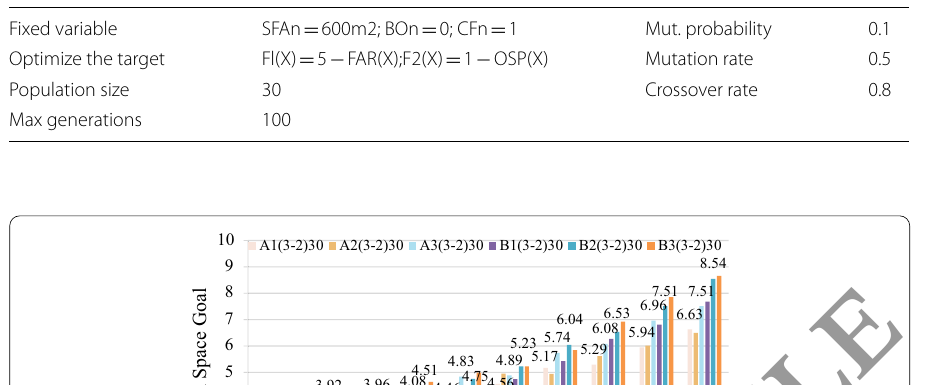
Table 3 Experiment 1–6 unified parameter settings Variable